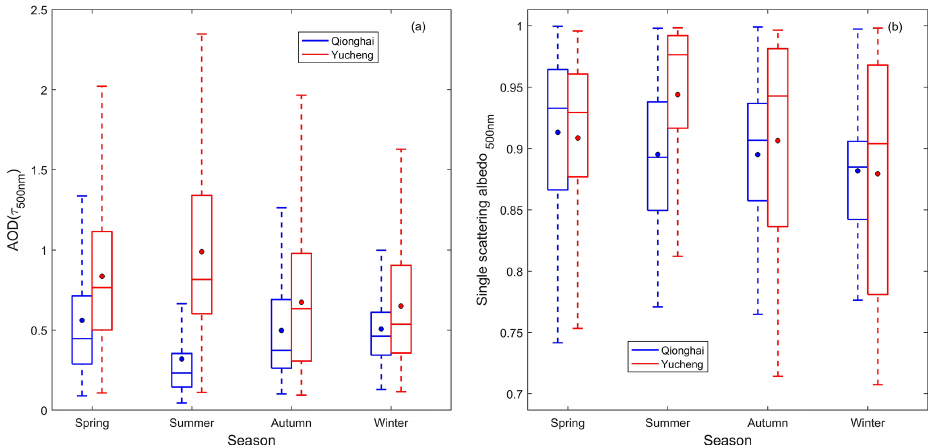
Figure 11. Seasonal variations in the AOD (a) and the SSA (b) based on SKYRAD V5.0 over Qionghai and Yucheng for the period from February 2013 to December 2015. The boxes represent the 25th to 75th percentiles of the distributions, while the dots and solid lines within each box represent the means and medians,